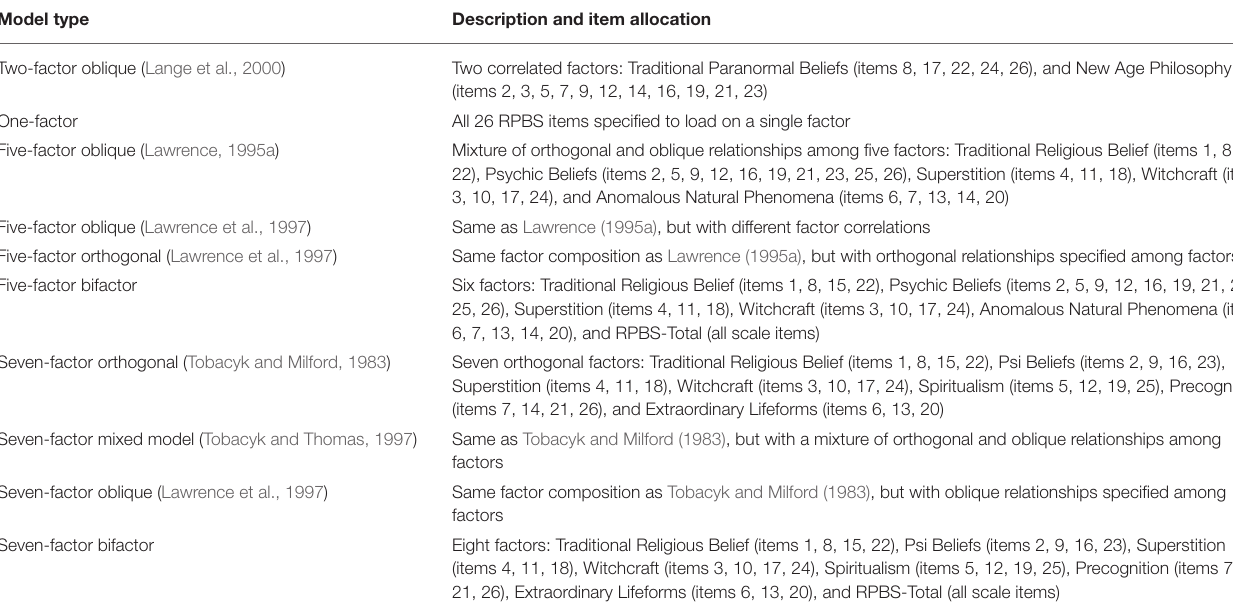
TABLE 1 | Competing factor models of the revised paranormal belief scale. Model